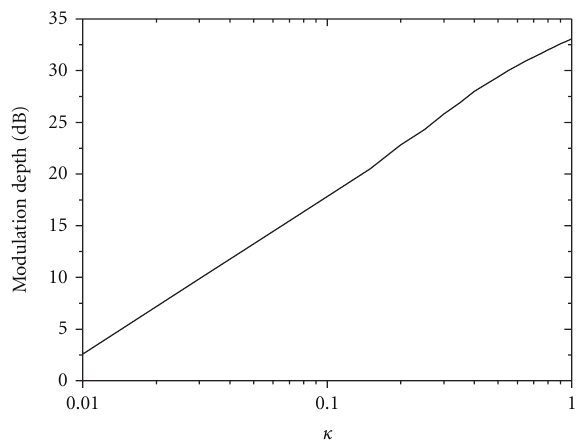
Figure 8: Modulation depth T ( κ ) /T ( κ = 0) of the side-coupled- cavity switch (Figure 5(a)) as a function of the imaginary part κ of the refractive index. Results are shown for w = 300nm, L = 210nm. All other parameters are as in Figure